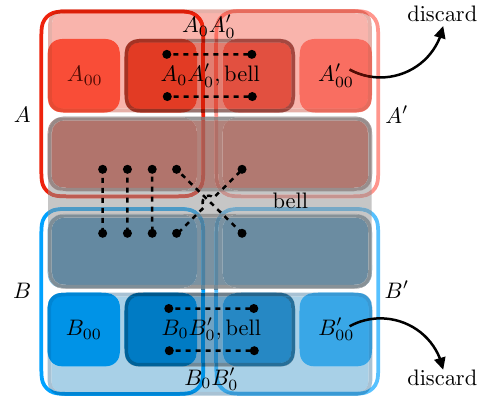
Figure 7 . Hilbert space decomposition and entanglement distillation of AB and its purification. primed factors (i.e., less ) equals e S ( ρ AB ) , because the state on the H A (cid:31) 00 ⊗ H B (cid:31) 00